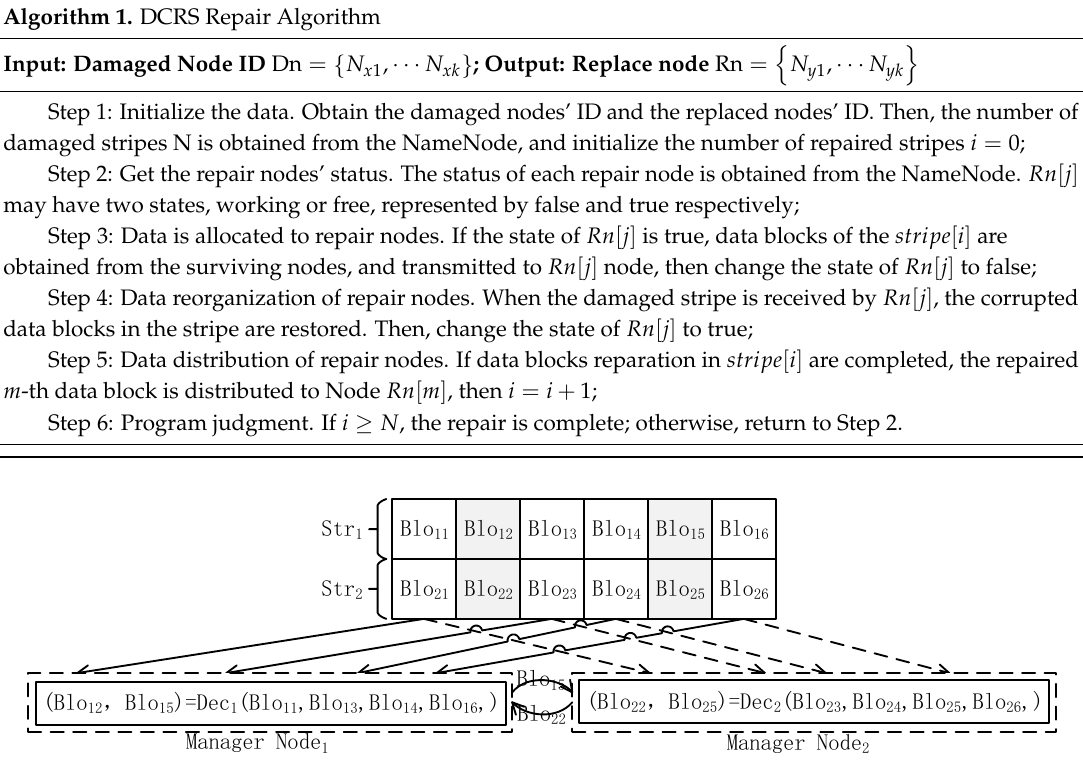
Figure 4. Distributed-Cross Repair Solution (DCRS) Repair Model.